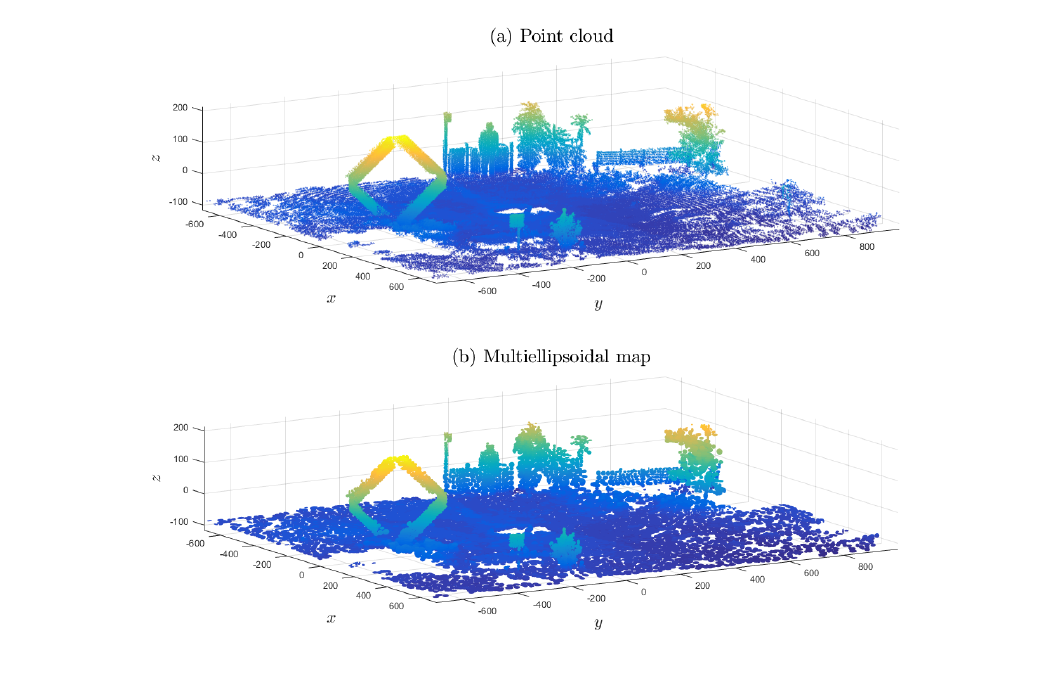
Figure 10. Experiment